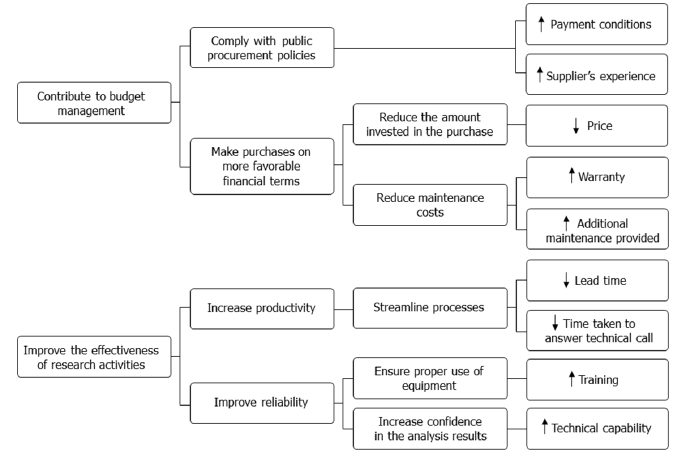
Fig. 1. Objectives and related criteria of the